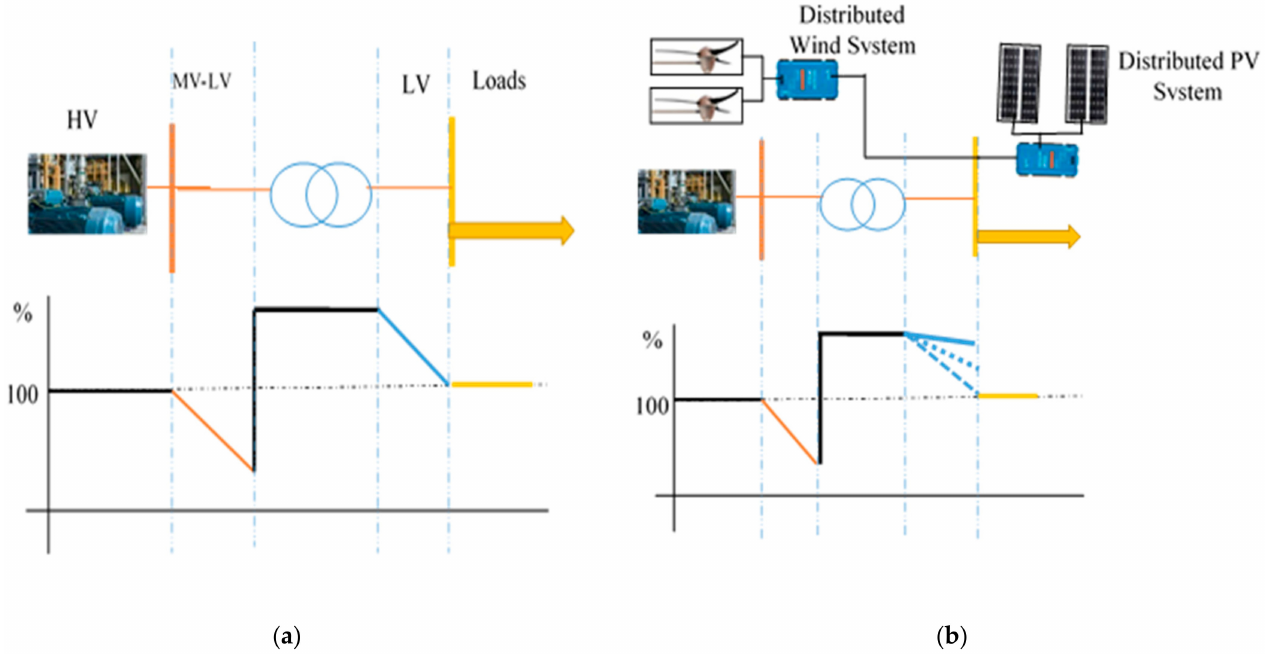
Figure 7. Illustration of voltage profile of network before and after RE integration: ( a ) Voltage profile at LV network with no distributed renewables; ( b ) Voltage profile at LV network with distributed